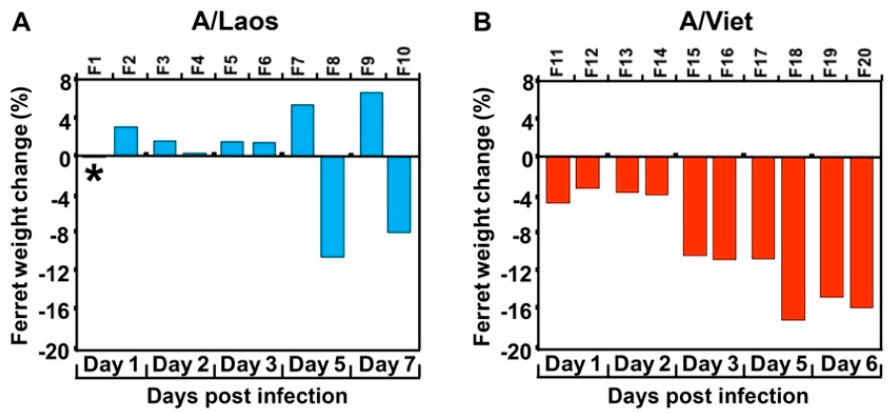
Figure 1. Weight loss induced by infection with avian and human H5N1 isolates. ( A ) Ferrets F1–F10 were infected with the avian H5N1 virus A/Laos (encoding PB2 627E) and ( B ) ferrets F11–F20 were infected with the human H5N1 isolate A/Viet (encoding PB2 627K). Ferrets were weighed immediately prior to virus inoculation on day 0 and again immediately prior to euthanasia on the indicated day of sampling. Values represent the percentage change from the initial ferret weights. * Indicates that a change in weight was not detected.